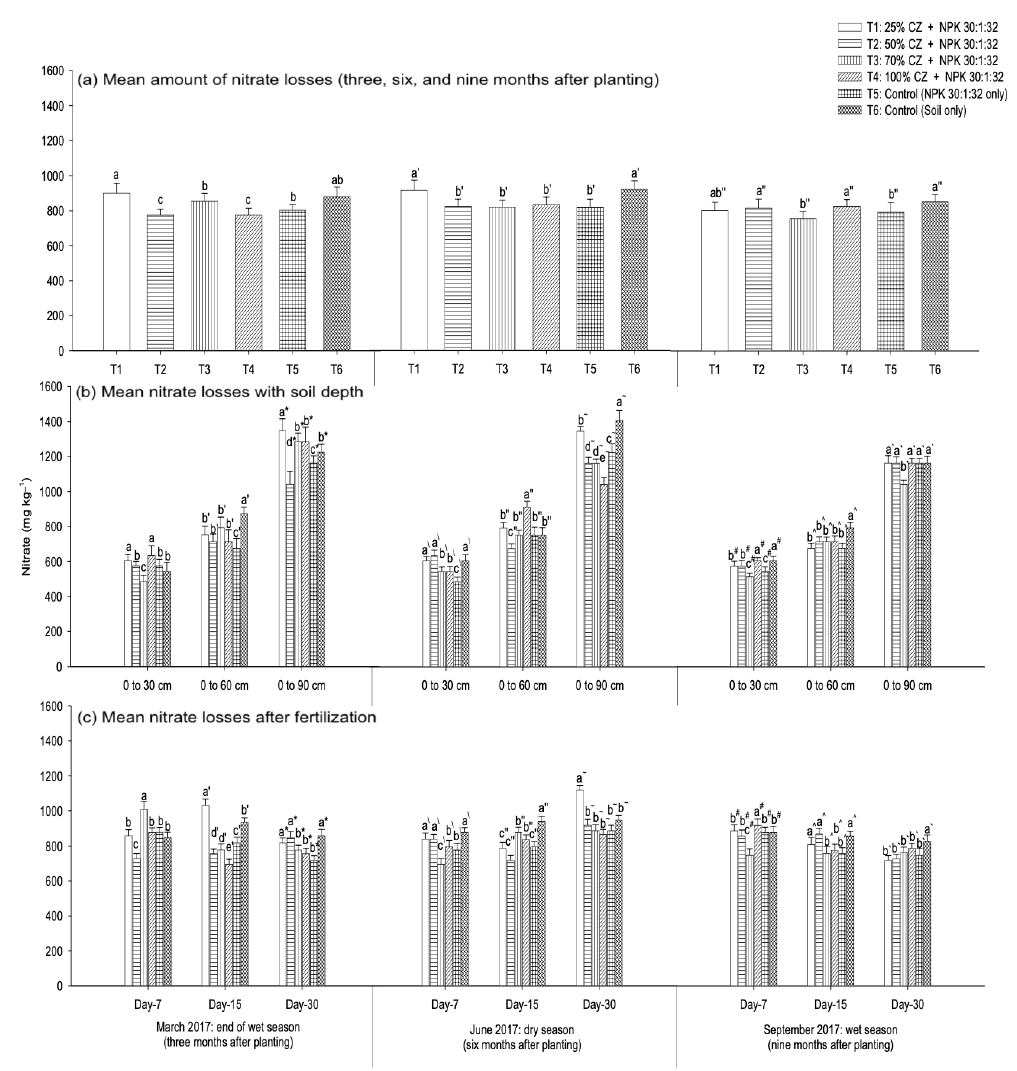
Figure 9. Amount of nitrate leached from pineapple-cultivated peat soils treated with clinoptilolite zeolite at different vegetative stages (three, six, and nine months after planting): ( a ) mean amount of nitrate losses, ( b ) nitrate losses with soil depth (0 cm to 30 cm, 0 cm to 60 cm, and 0 cm to 90 cm), and ( c ) nitrate losses after fertilization (seven, fifteen, and thirty days) throughout the wet (March and September 2017) and dry (June 2017) seasons. Error bars indicate the standard error of the mean (n = 162). Means with different letters are significantly different using Tukey’s test with p ≤ 0.05. CZ: clinoptilolite zeolite. Letters without primes, single primes, and double primes represent mean nitrate losses respectively at three (March 2017), six (June 2017), and nine (September 2017) months after planting. Letters without primes, single primes, and asterisks represent nitrate losses at the end of the wet season (March 2017), letters with backslashes, double primes, and tildes represent the dry season (June 2017), and letters with hashes, carets, and backticks represent the wet season (September 2017).